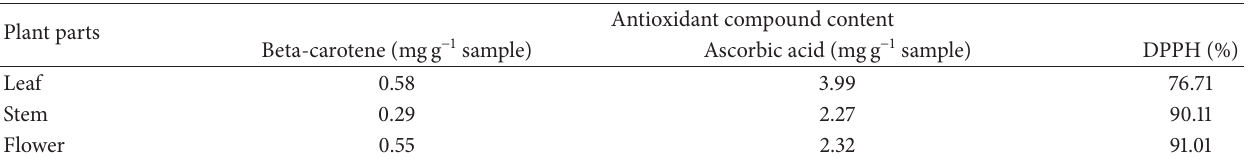
Table 7: Ascorbic acid and beta-carotene content and 1,1-diphenyl-2-picrylhydrazyl (DPPH) radical-scavenging activity of different parts of Thai